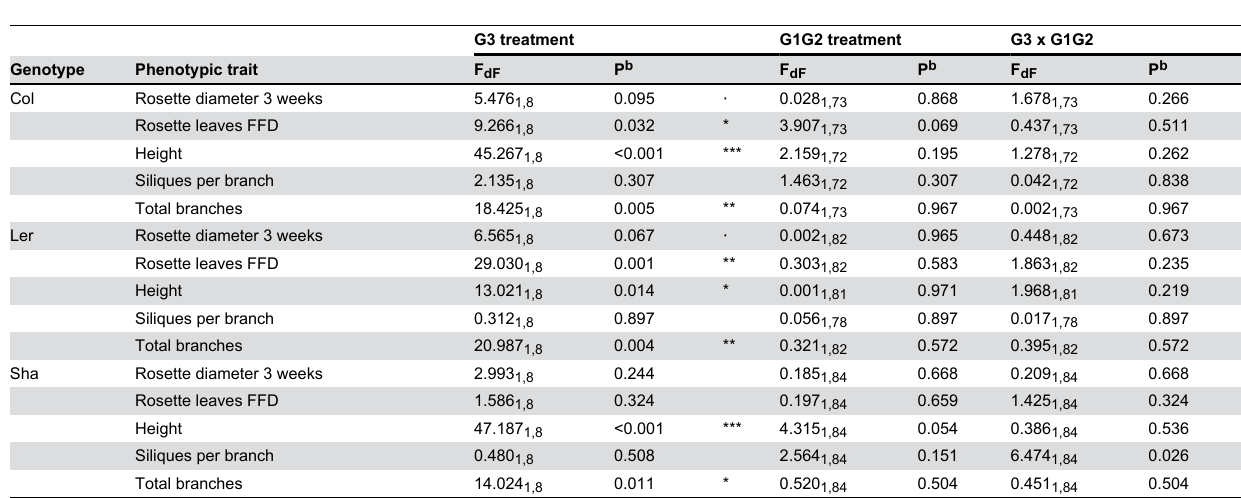
Table 1. Effects of G3 and G1G2 salt treatments and interactions on phenotypic traits were calculated for three genotypes using linear mixed models with trays as random